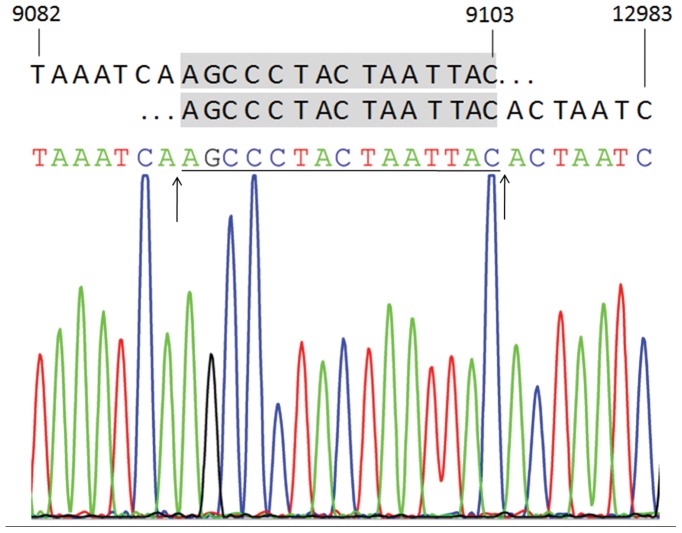
Schematic diagram and sequences of the mtDNA 3873-bp deletion (nt9089–nt12961 or nt9104–nt12976).Bold black letters indicate the nucleotide sequences flanking the breakpoints of the deleted mtDNA, and shaded letters indicate the direct repeats. The sequences of the PCR products are shown below the schematic diagram. The arrowheads point to the possible breakpoints.